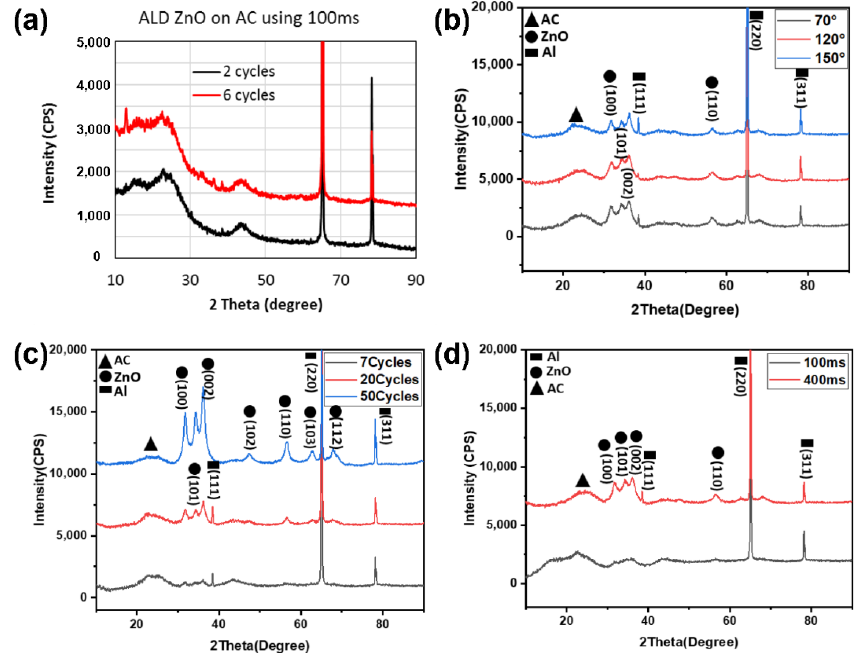
Figure 2. XRD patterns of ALD ZnO-coated AC under different conditions: ( a ) 100 ms at 120 °C for 2 and 6 cycles; ( b ) 100 ms and 400 ms at 70 °C for 20 cycles; (c ) 400 ms at 150 °C for 7, 20, and 50 cycles; ( d ) pulse time of 400 ms for 20 cycles, at 70, 120, and 150 °C.